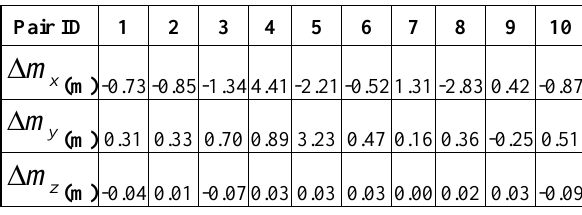
Table 2. Check planes centroids differences After the transformation parameters were calculated, they were applied to the LiDAR data points to transform them to the coordinate system of the DSM. Then the overlap area between the convex hulls of the transformed LiDAR buildings and their corresponding DSM buildings was calculated. Their estimated mean value is 98.60%. The boundary of a building was selected as an example to display the transformation performance. In Figure 2, the blue line is the building boundary of the photogrammetric DSM and the red line is the building boundary of the LiDAR data.